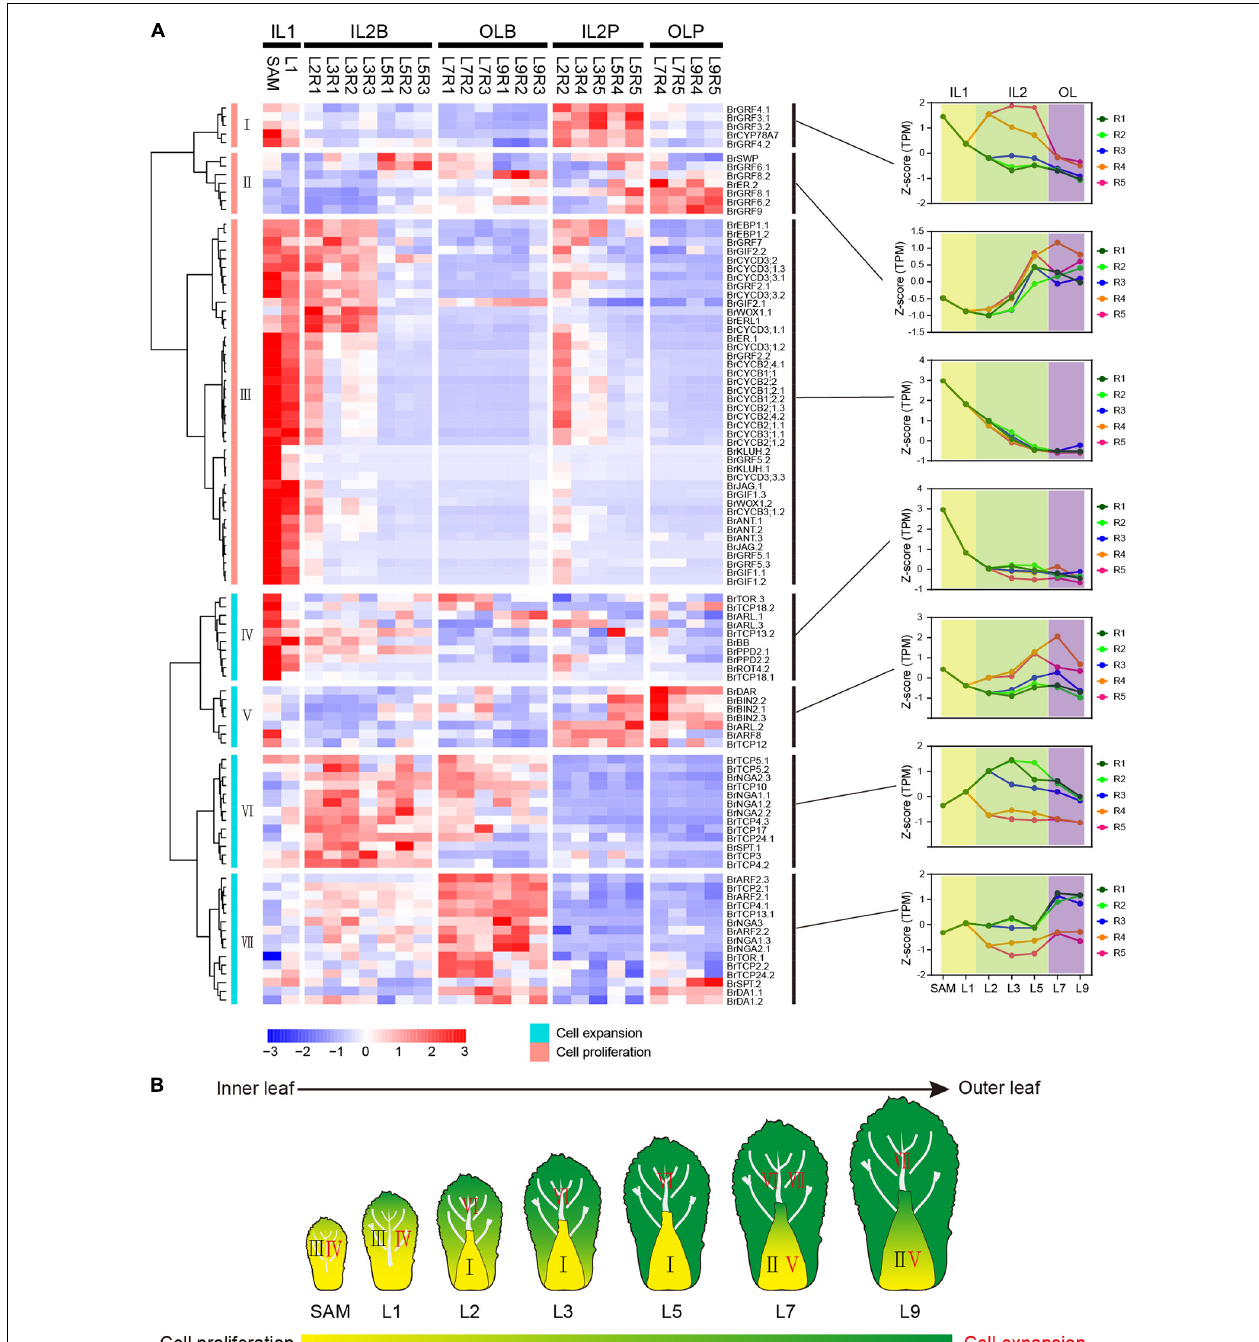
FIGURE 3 | Expression pattern of cell proliferation and cell expansion genes. (A) Hierarchical clustering analysis of cell proliferation genes and cell expansion genes. For each gene, expression data were Z-score standardized. (B) Expression model of cell proliferation genes and cell expansion genes in Chinese cabbage at